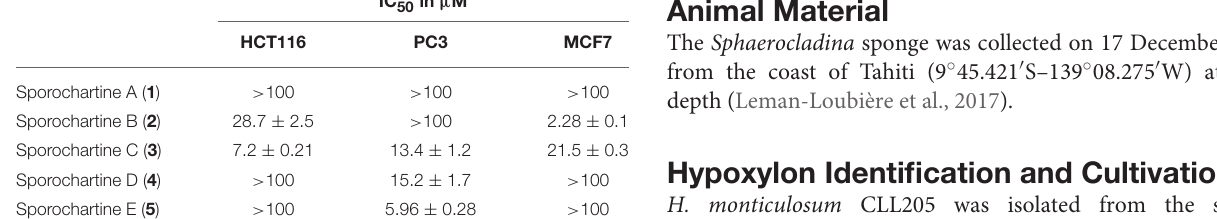
TABLE 3 | IC 50 values recorded for sporochartines A–E against three cancer cell lines, HCT-116 (human colon carcinoma), PC-3 (human prostate cancer cell lines), and MCF-7 (human breast cancer cell line). IC 50 in µ M HCT116